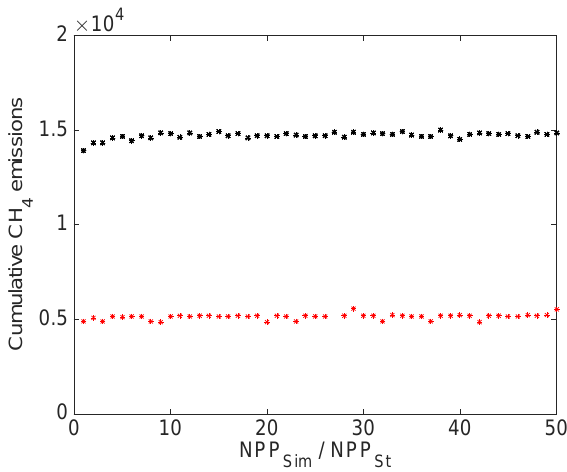
Figure A1. Dependence of the cumulative methane fluxes com- puted from the end of April to the end of October on NPP forcing. The x axis shows the ratio between the simulation NPP (NPP Sim ) and the NPP of the Standard configuration (NPP St ). The vertical scale is the same as in Fig. 7, to show that differences among the simulations are small. Black crosses show cumulative emissions for the model in the Microtopography configuration, and red crosses cumulative emissions for the model in the Single Bucket configu- ration. We did not vary the tuning parameter R 0 , which partly ac- counts for the dependence on NPP of the methane emission